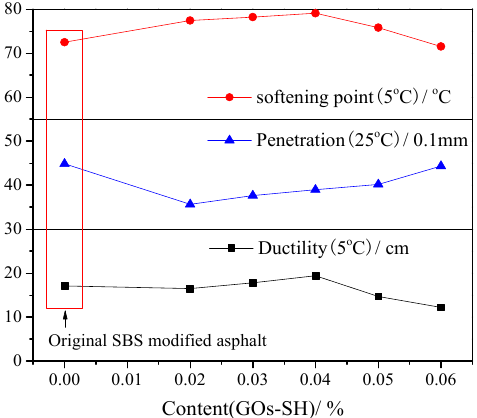
Figure 3. Tests results of modified asphalt with different GOs-SH content.